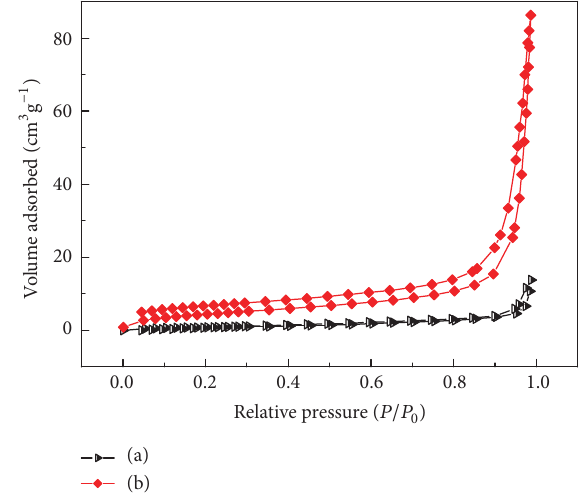
Figure 4: XRD patterns of (a) Fe(OH) 3 @PMMA composite micro- spheres and (b) magnetic microspheres.